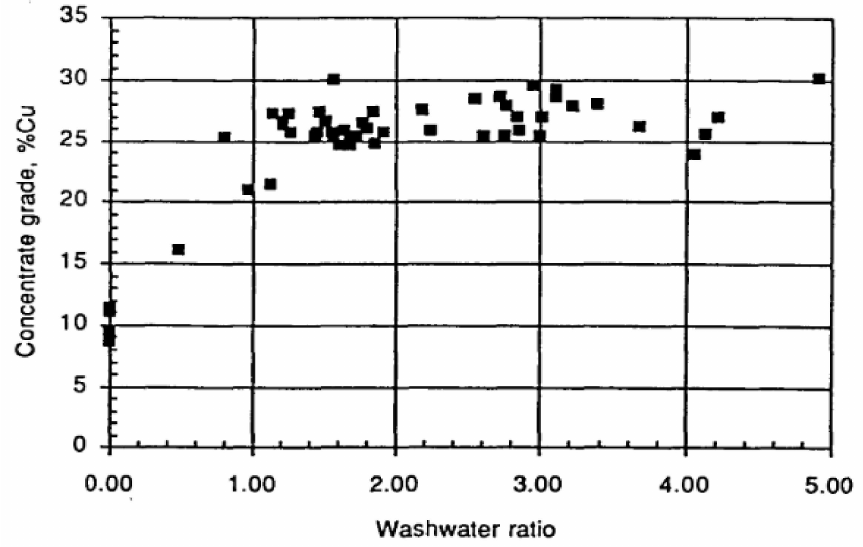
Figure 13. Effect of wash-water ratio on grade in the flotation of fine copper retreatment stream [34]. A summary of the general froth washing methods and delivery mechanisms discussed above is given in Table